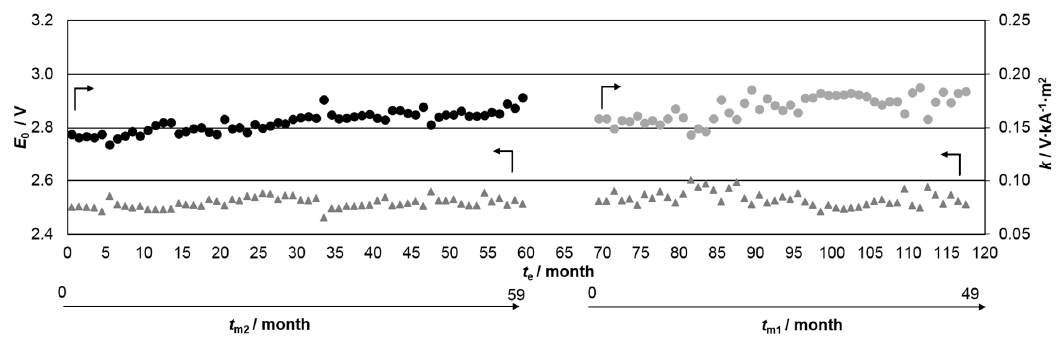
Figure 3. After their replacement (corresponded to #e2 and #m2 period), E 0 values are between 2.46 and 2.56 V and k -factor between 0.13 and 0.18 V · kA − 1 · m 2 —cf. Figure 3. These results are within the reported normal range of k -factor. In this period, the k -factor values are smaller, which indicates a smaller ohmic resistance related to the use of different type of membranes.